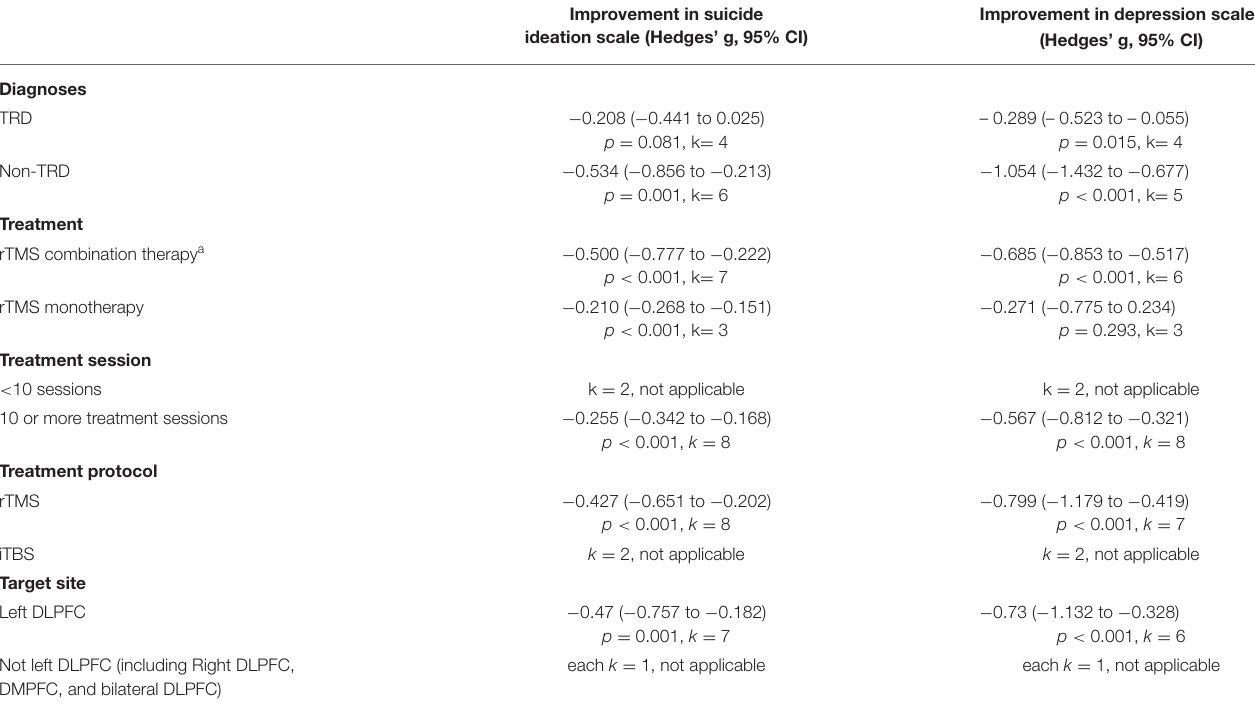
TABLE 2 | Subgroup analyses of rTMS on suicide ideation reduction and depression